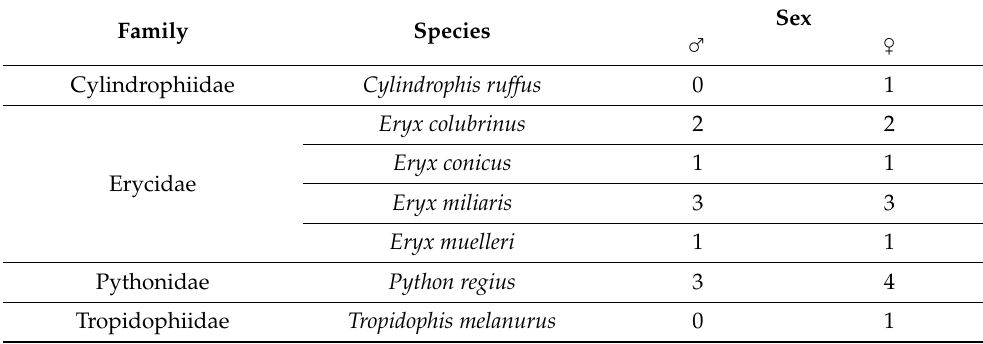
Table 1. List of examined